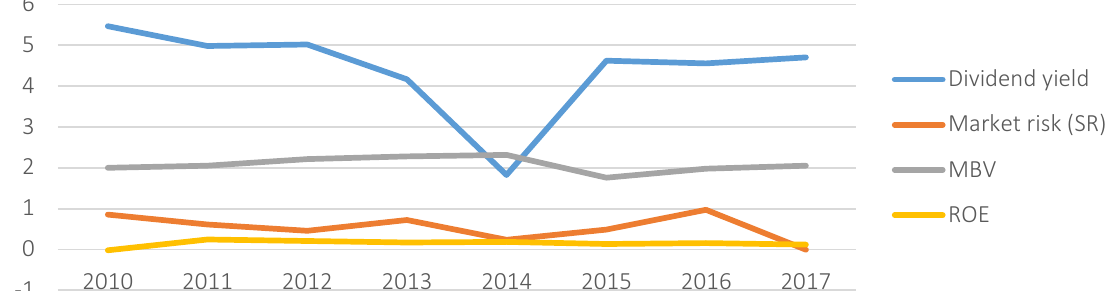
Figure 2. Mean (A1) of dividend yield, stock beta, MBV, and ROE